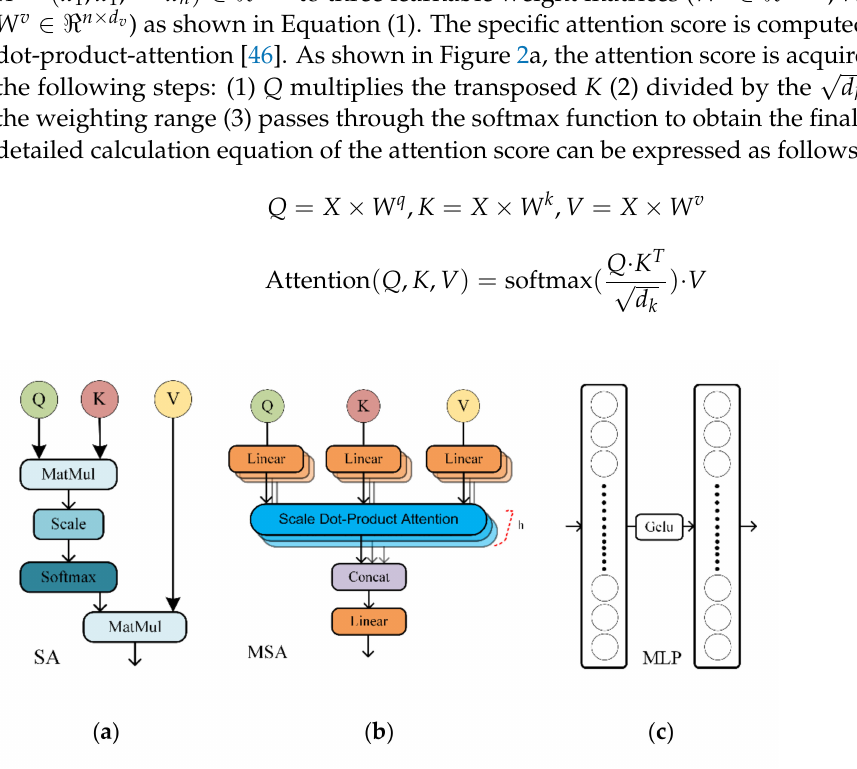
Figure 2. The structure of Self Attention ( a ), Multi-Head Self Attention ( b ), Multi-Layer Perceptron ( c ). ( a ) represents the standard calculation of the self-attention score, ( b ) is the calculation of self-attention score in transformer. ( c ) is a part of